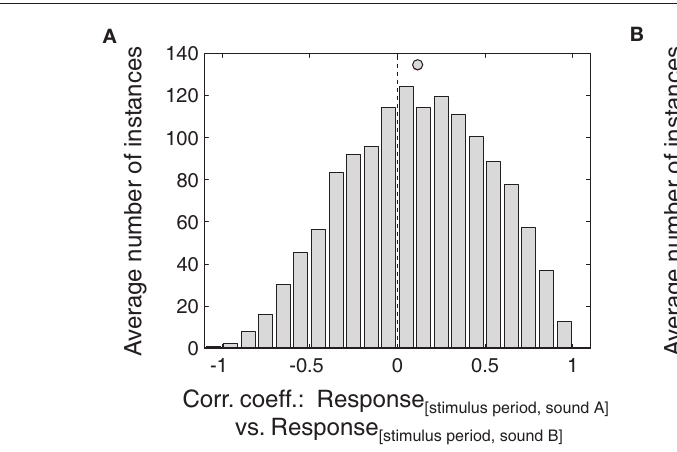
FIgure 9 | effects of eye position, comparing stimulus period responses across different sound locations, in IC neurons. This analysis involved comparing the stimulus period responses for one sound location (sound A) against the stimulus responses for another location (sound B). (A) and (B) show